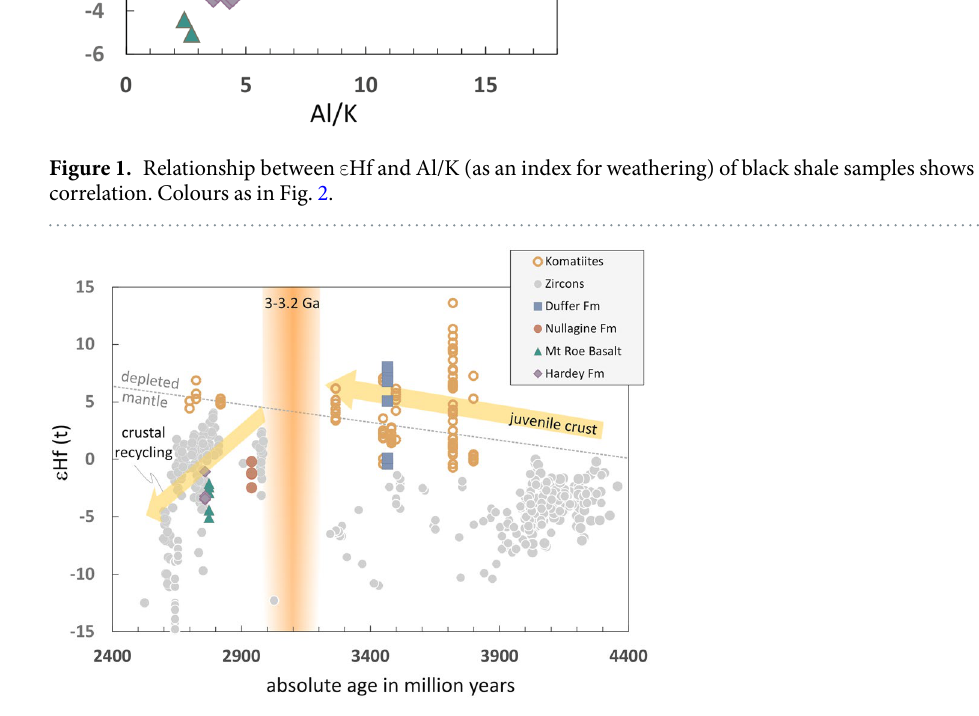
Figure 2. The ε Hf initial vs absolute age plot of the black shale samples, compared to zircon 47,48 and komatiite 49–51 data. It shows komatiites as potential source for the older Duffer Formation. Younger Pilbara black shales show lower initial Hf. Black shales older than 3–3.2 Ga show the predominant process of formation of juvenile crust, whereas younger samples indicate crustal reworking as the dominant process. From this data set, the change in the processes can be dated to be not older than 3.2